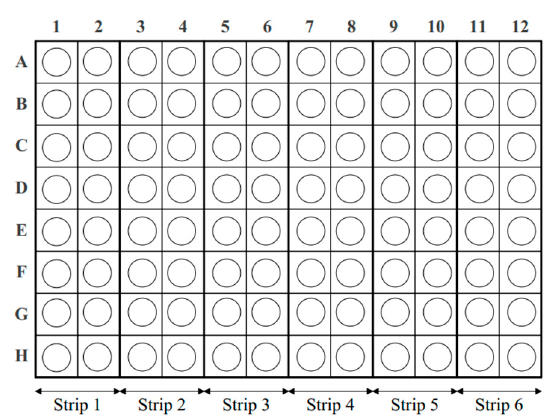
Figure 1. Example of laboratory